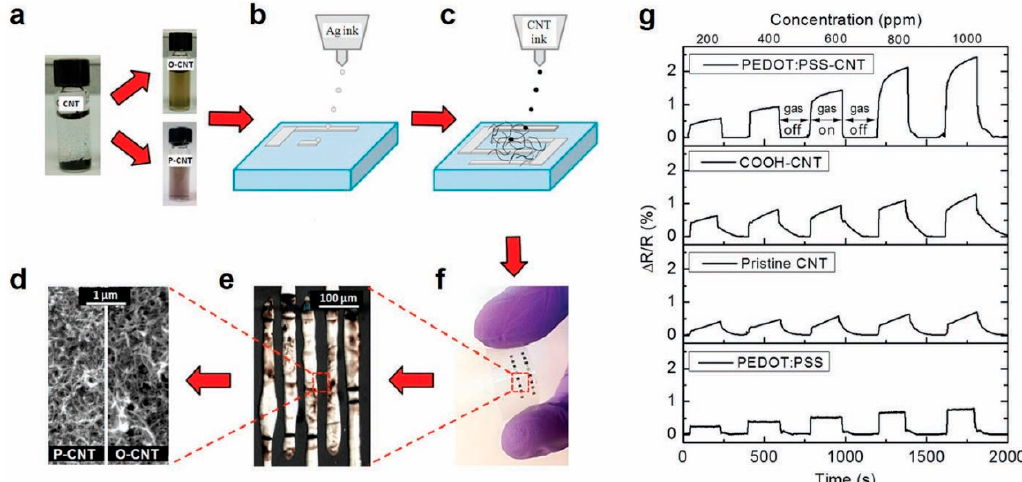
Figure 6. Fully printed and flexible CNTs based gas sensor: ( a ) CNTs’ functionalization with carboxylicacid (O-CNTs) and PEDOT:PSS (P-CNTs); ( b ) printing of Ag electrodes; ( c ) printing of CNTs; ( d ) photograph of the sensor on flexible substrate; ( e ) optical microscope image shows the printed silver interdigitated electrodes and ( f ) SEM image shows the printed carbon nanotubes. ( g ) Sensitivity of the printed ethanol vapor sensor (operated at 5V) with different CNTs functionalization methods and different gas concentrations. Reproduced with permission from Elsevier [53].